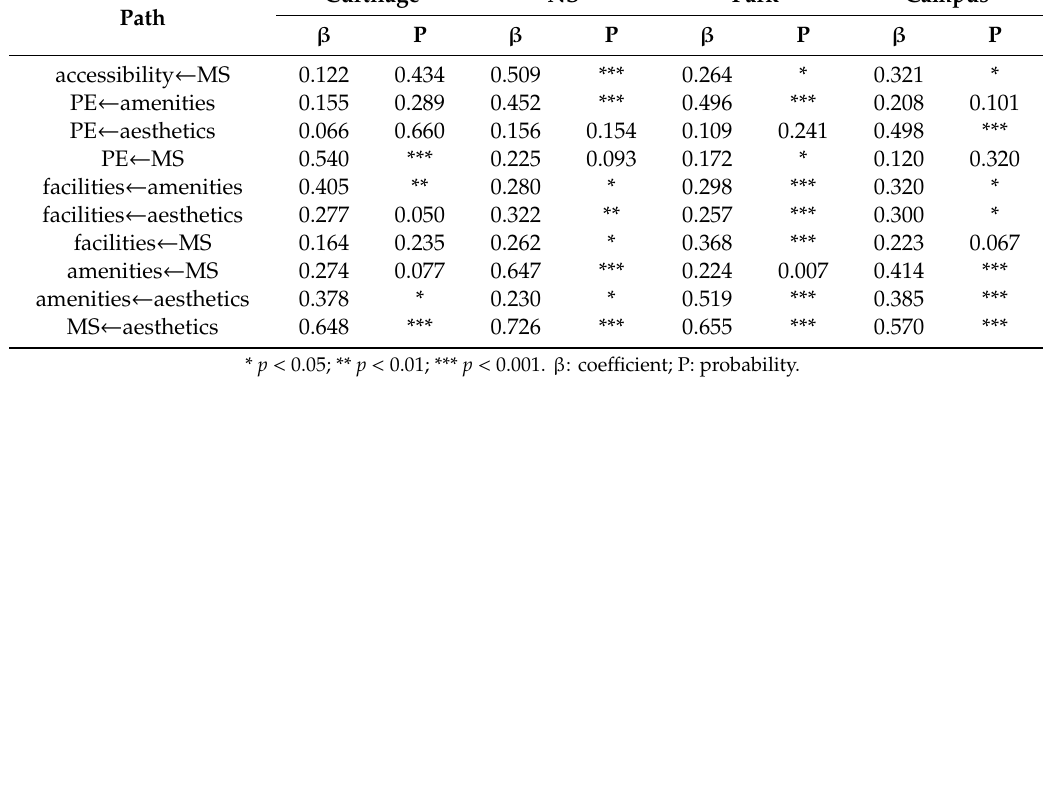
Table A4. The path coe ffi cient and significance of the relationship among the elements in groups. Path